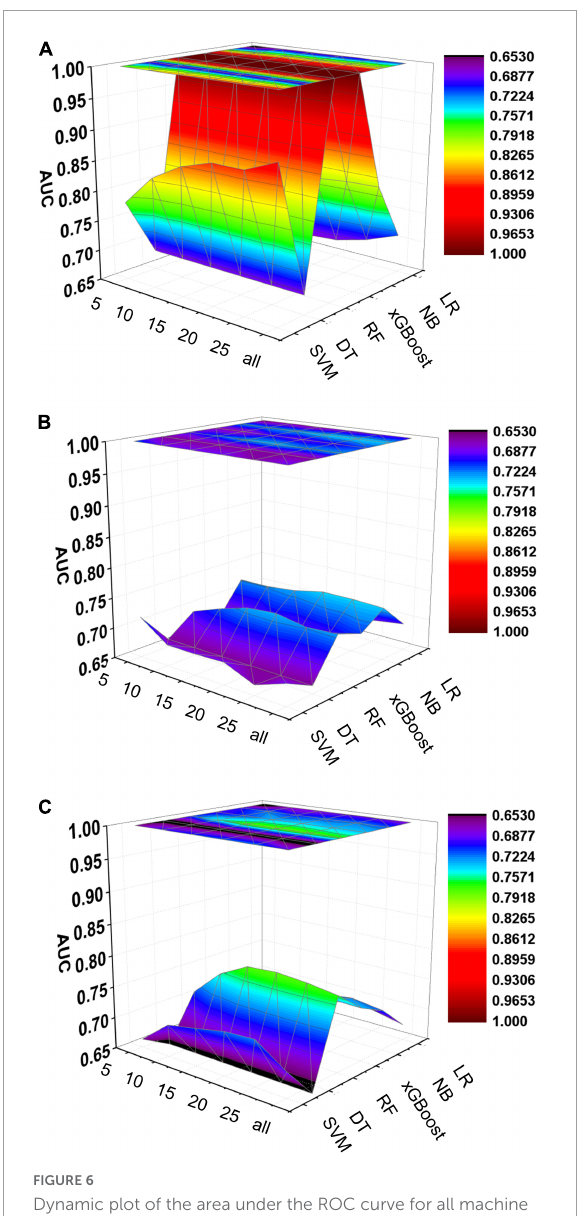
FIGURE6 Dynamic plot of the area under the ROC curve for all machine learning models; training cohort (A) ; test cohort (B) ; validation cohort (C) . The x-axis represents the number of variables included in the model, the y-axis represents different kinds of models, and the z-axis represents the AUC values of each